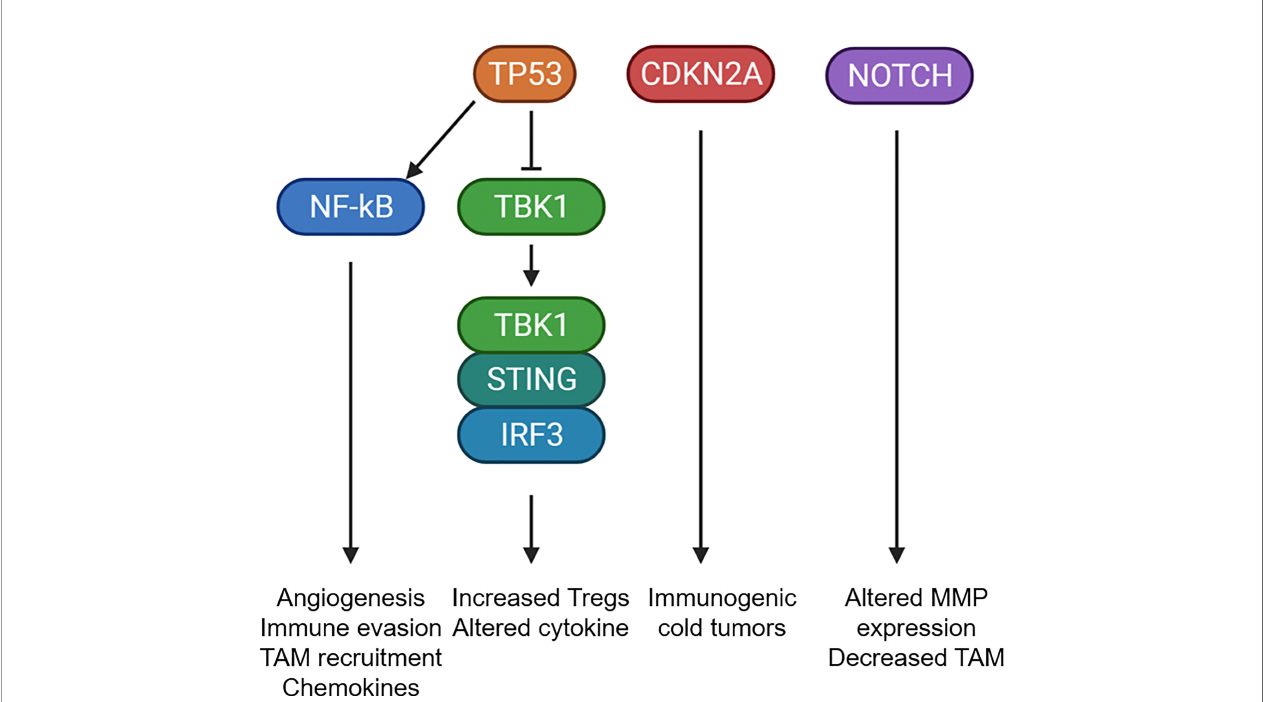
FIGURE 3 | Mutational changes that potentially alter the tumor microenvironment. Schematic diagram showing the common mutational changes in OPL can impact the immune microenvironment. TP53 mutants can activate NF-kB or inhibit the STING pathway to alter cytokine expression, increase TAM recruitment, increate Treg recruitment. CDKN2A mutants has been associated with immunogenic cold tumors through currently unknown mechanisms. NOTCH1 mutants was associated with altered MMP expression and decreased TAM in fi ltrations. Created with